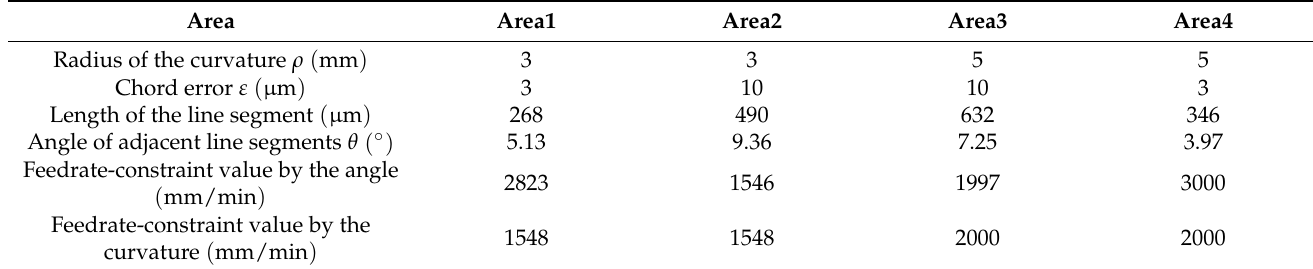
Table 2. Geometric information of the machining path and its feedrate-constraint